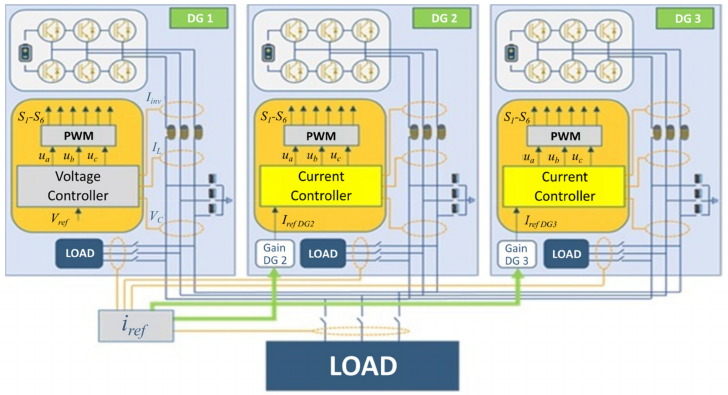
Figure 2. Island